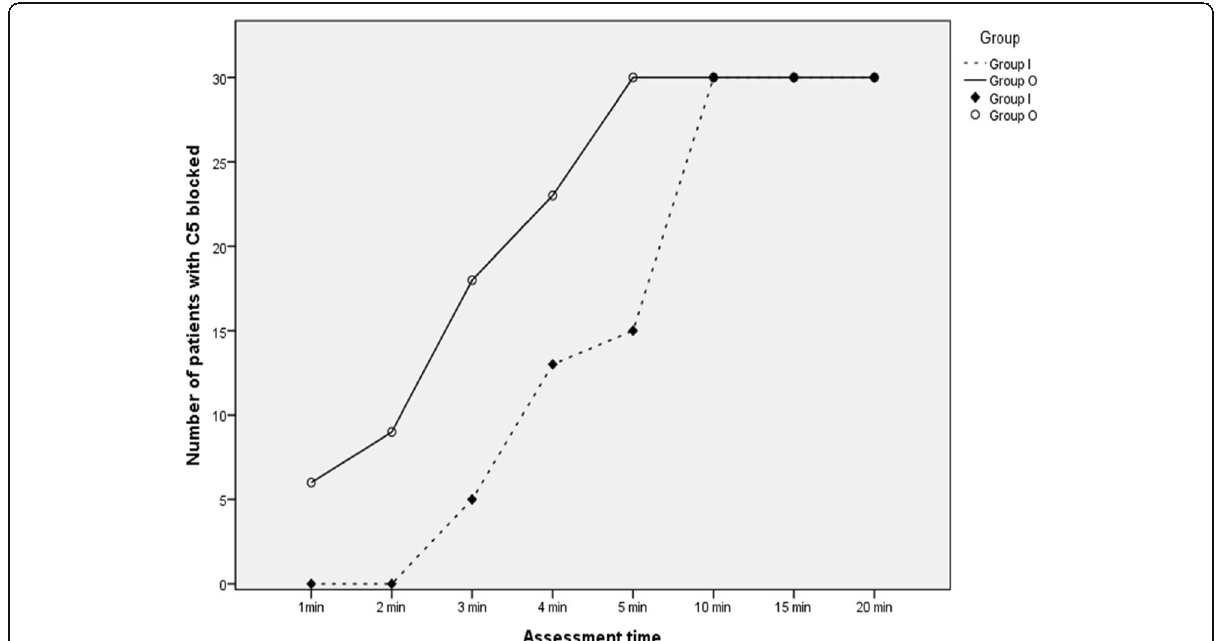
Fig. 1 Onset and progression of C 5 block over the first 20 min